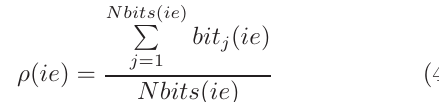
that which we use to build the chromosome, i.e.